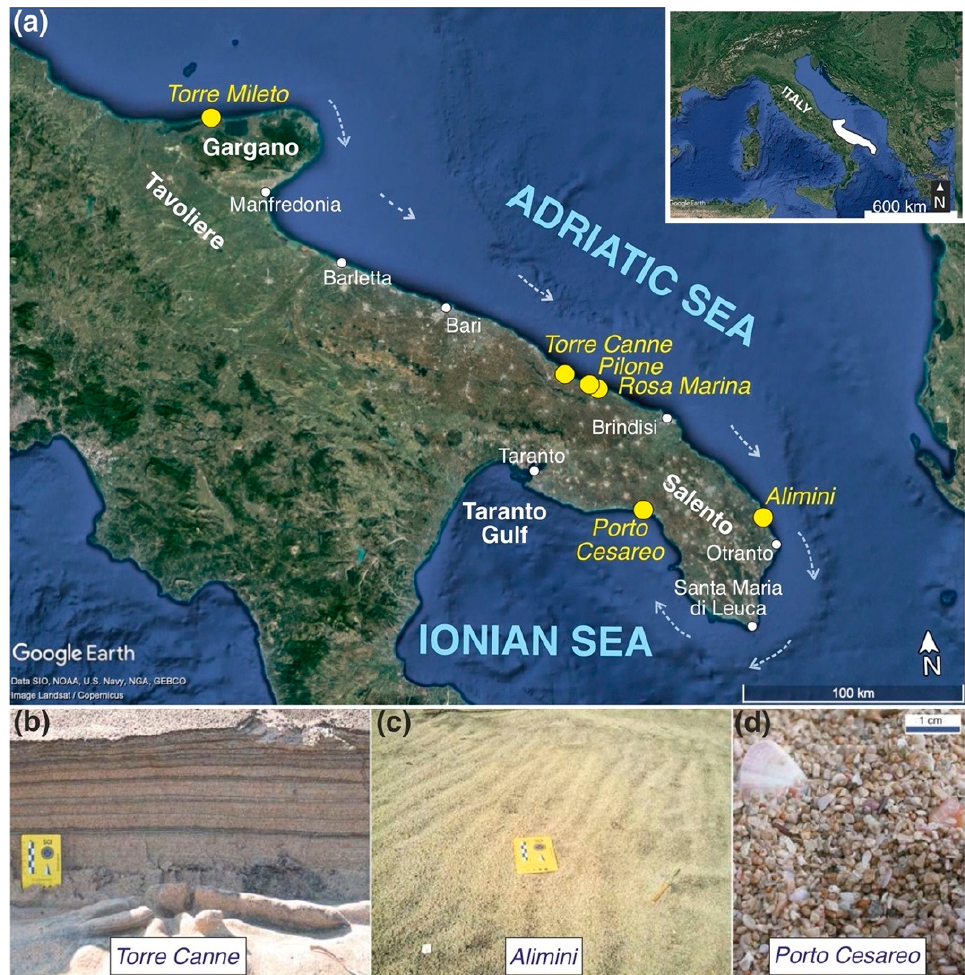
Figure 1. ( a ) Geographical location of a few sandy beaches (yellow circle) characterizing the Apulian littoral stretch. The white arrows indicate the general alongshore current influencing the sediment transport on the Adriatic and the Ionian Sea; ( b – d ) Macroscopic features variability of the Apulian beach sands in terms of color and grain size (modified from [20]). Table 1. Techniques for beach monitoring applied in the different sectors of the Earth Sciences. Each color represents a scientific sector with the relative authors. GPR: Ground Penetrating Radar, SSS: Side Scan Sonar; SBP: Sub Bottom Profiler. Geomorphology [44–53]; Sedimentology [54–61];